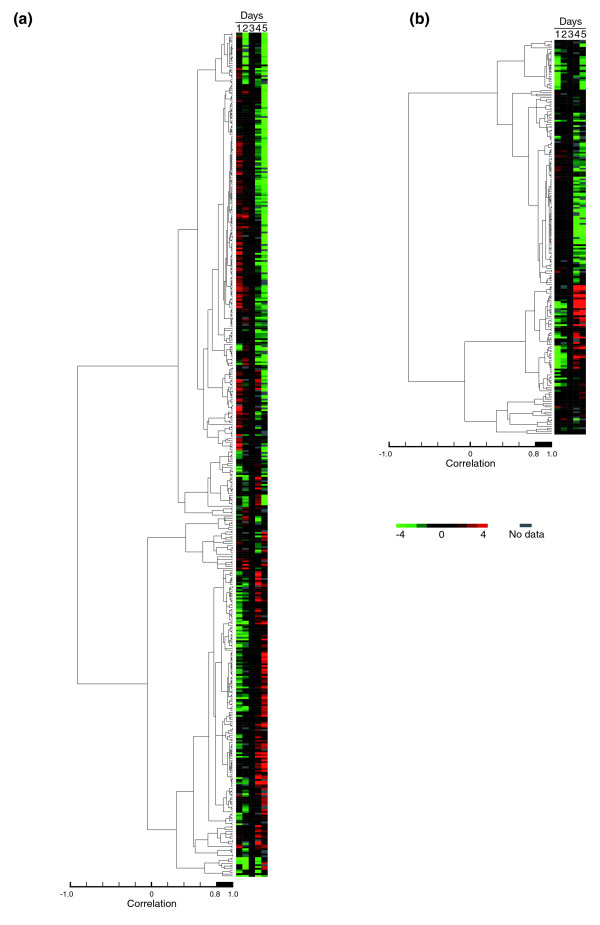
Average-linkage clustering of proteins quantified in the honey bee larvae. Proteins that were quantified in either or both the (a) tissue or (b) hemolymph for at least four out of five tested days were arranged by hierarchical clustering using software described in [46]. All expression values, shown relative to day 3 (= 0, black), have been natural log-transformed (>0, red; <0, green; no data, grey). These proteins, which have been manually annotated with a function and category, are calculated for enrichment within a node (results in Table 3) if the node correlation value is >0.8 (see thick bar on scale).